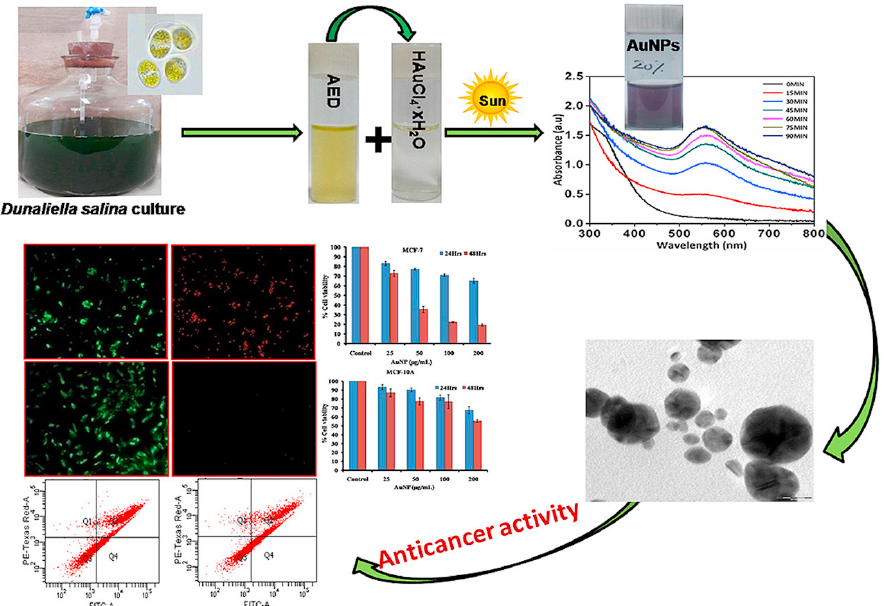
Figure 7. Green synthesis of gold nanoparticles from Dunaliella salina, UV–Vis characterization spectra, and in vitro anticancer activity on breast cancer cell line. Reprinted with permission from Ref. [109]. Copyright 2019 Elsevier.